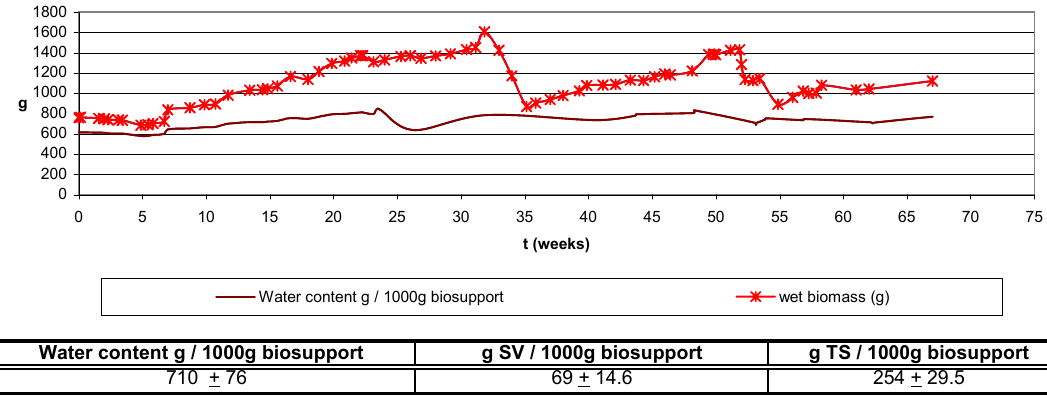
Figure 14. Biofilter water content and wet